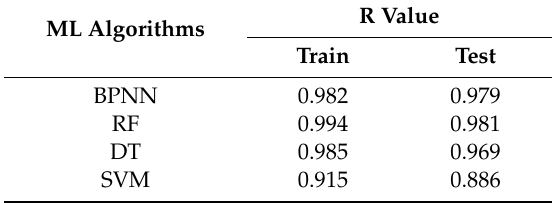
Table 1. The 4 ML algorithms for predicting the correlation coefficient R value of the adsorption